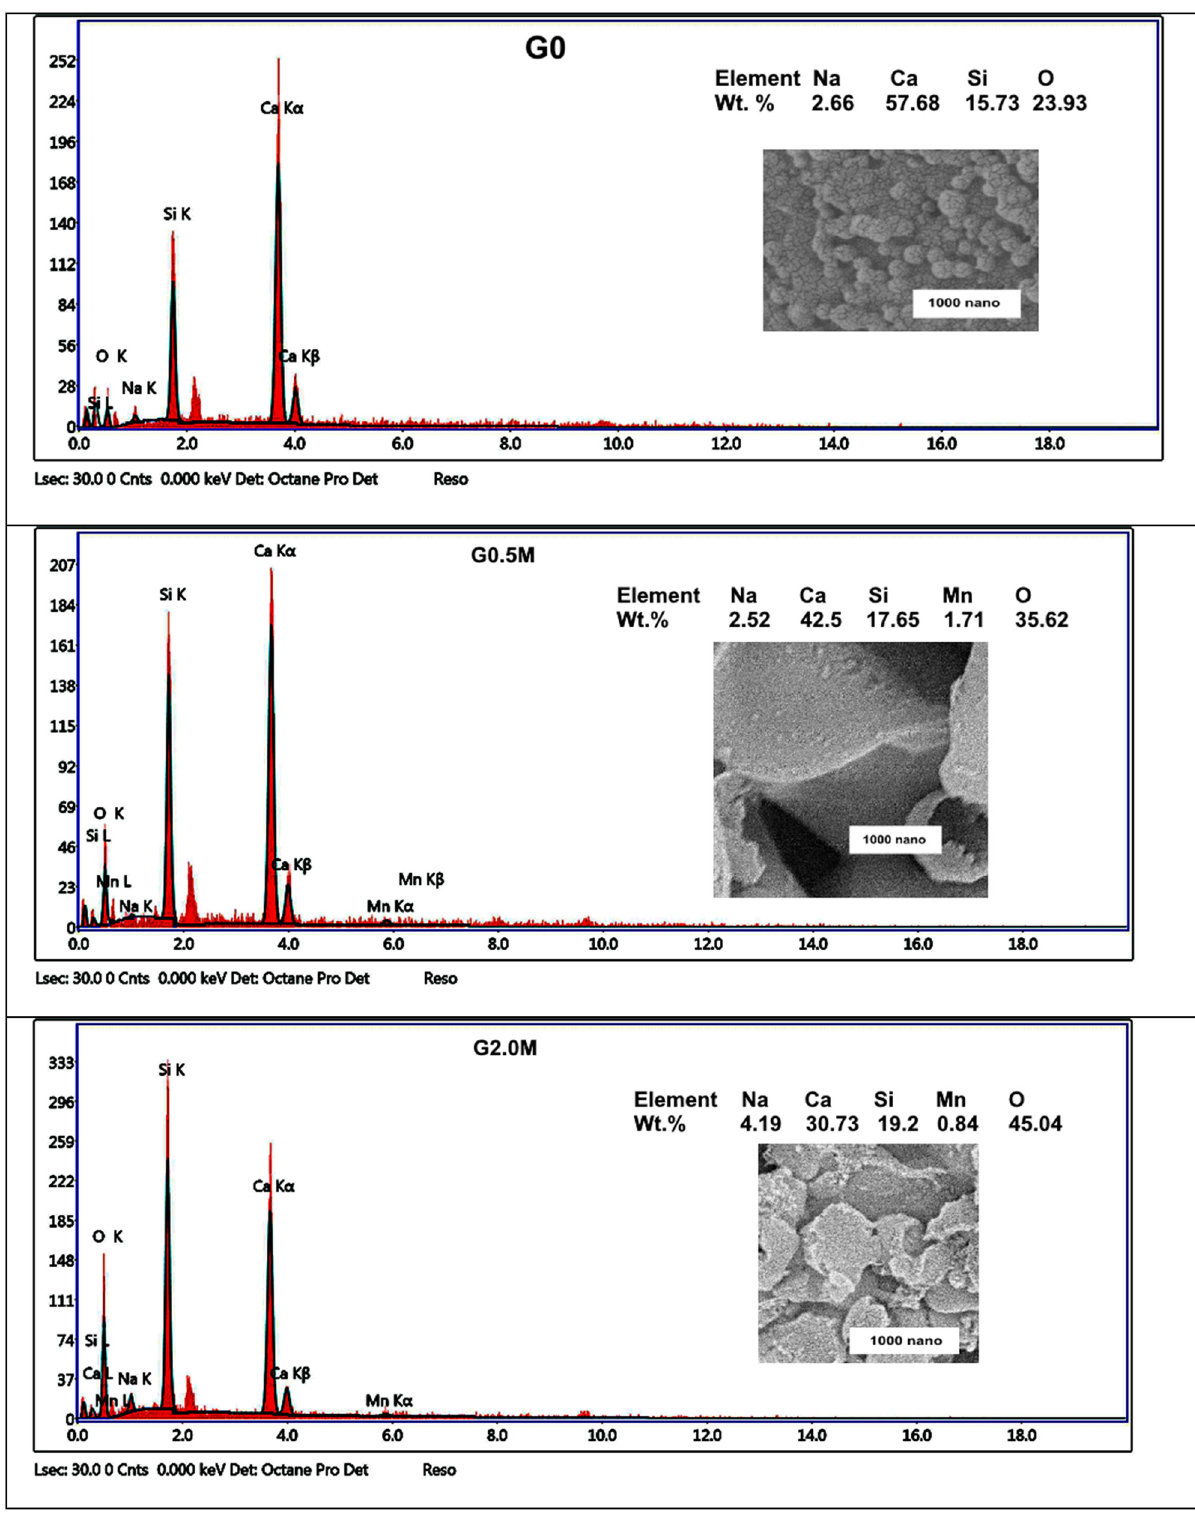
Figure 5: EDX microanalysis of G0, G0.50M and G2.00M glasses sintered at 1,100°C/2